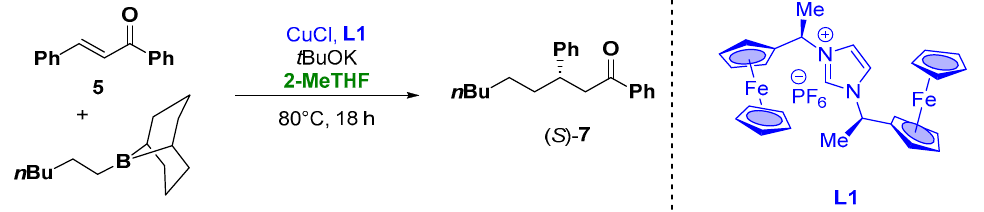
Figure 7. Enantioselective Michael-type addition of organoboranes to chalcones.